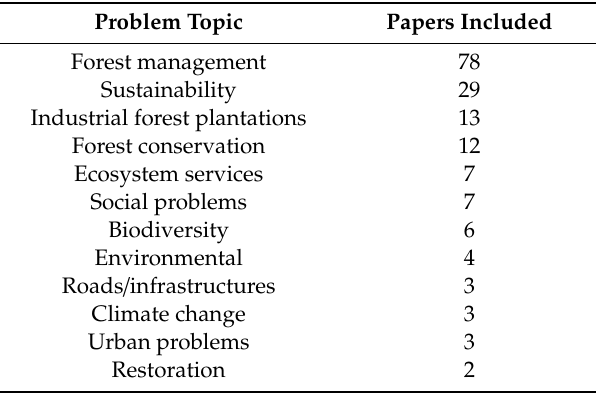
Table 3. Topic of the problem analysed.